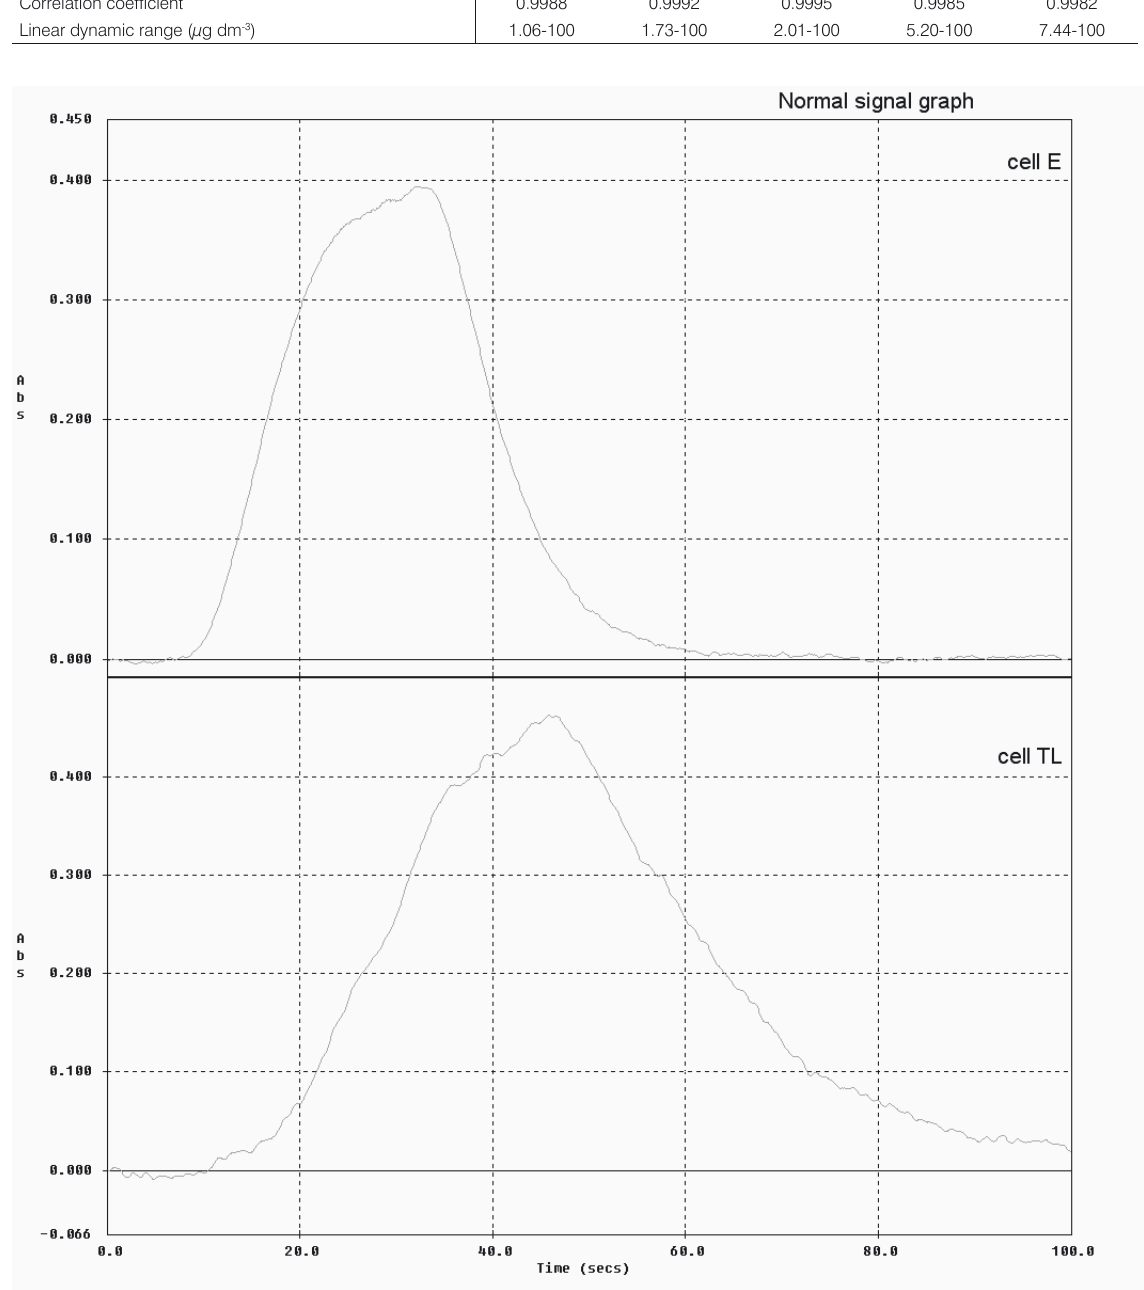
Figure 6. Time dependence of absorbance signal for cells E and TL in FIA mode: I = 0.7 A (cell E ) or 1.2 A (cell TL ), v